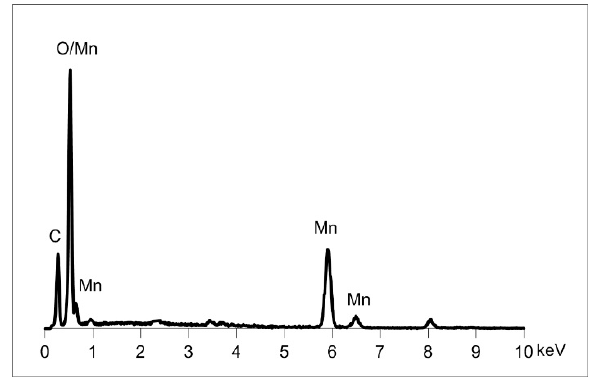
Figure 9. SEM / EDS spectrum showing the elemental composition of sparse admixtures of rhodochrosite (MnCO 3 ) found in CMTS the products of syntheses lasting 1 day, 3 days, and 2 times a week.